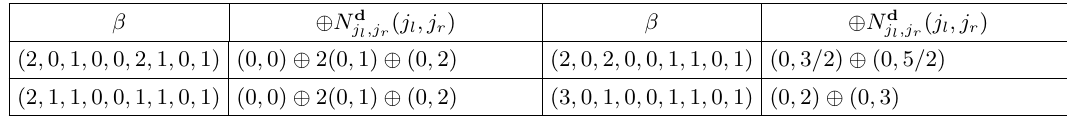
Table 24 . Refined BPS invariants of 6d n = 7 , E 7 model up to total degree 8. For those that are not determined by the vanishing blowup equations, we mark them with